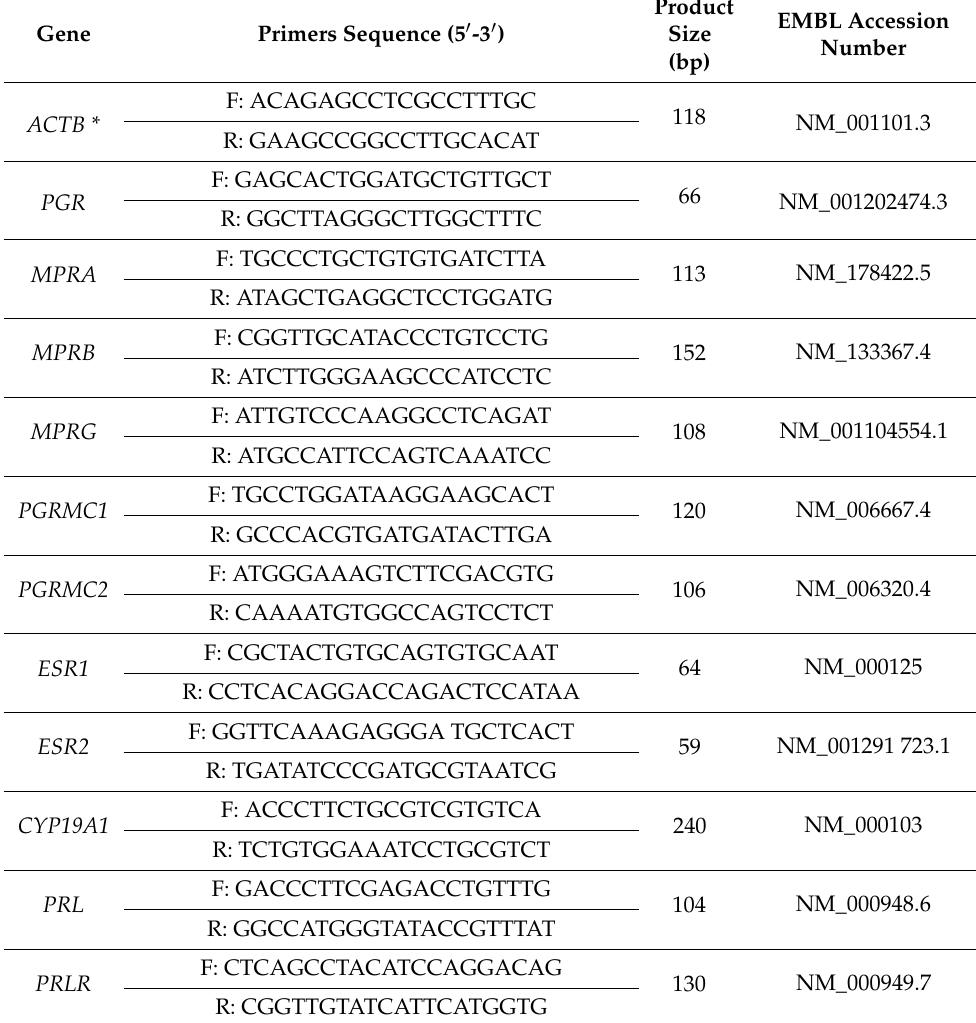
Table A1. Sequences of primers used in the q-RT-PCR